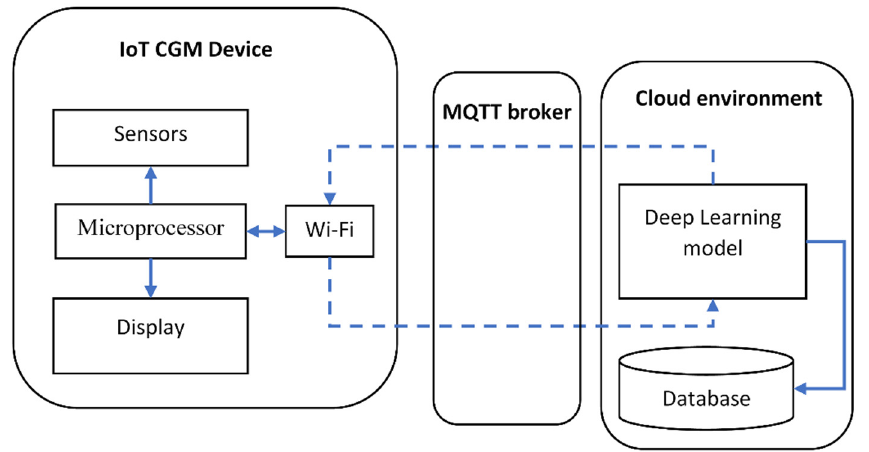
Figure 4. The proposed system architecture .